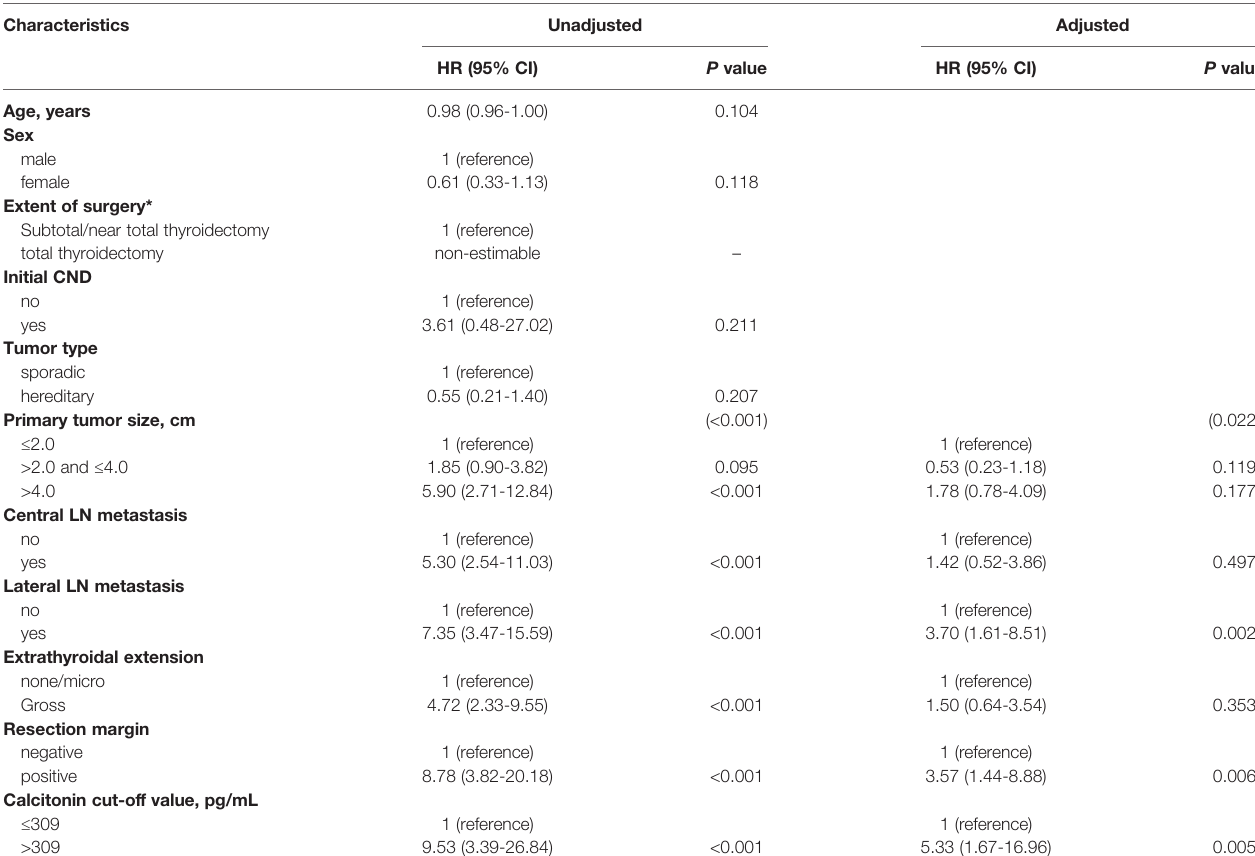
TABLE 4 | Multivariable analysis of disease-free survival.